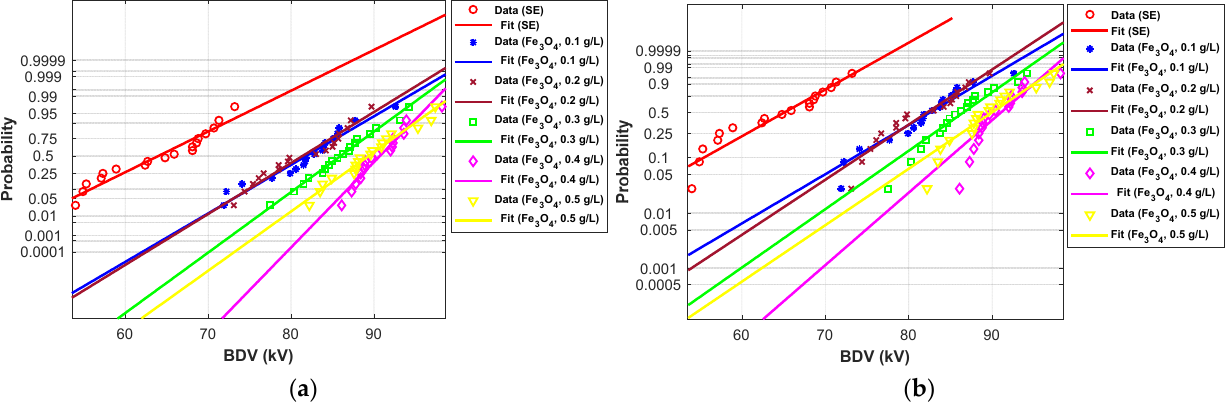
Figure 11. Probability plot of breakdown voltage data of SE-based nanofluids with Fe 3 O 4 (20 nm) for the 2 mm electrode gap; ( a ) normal and ( b ) extreme value.